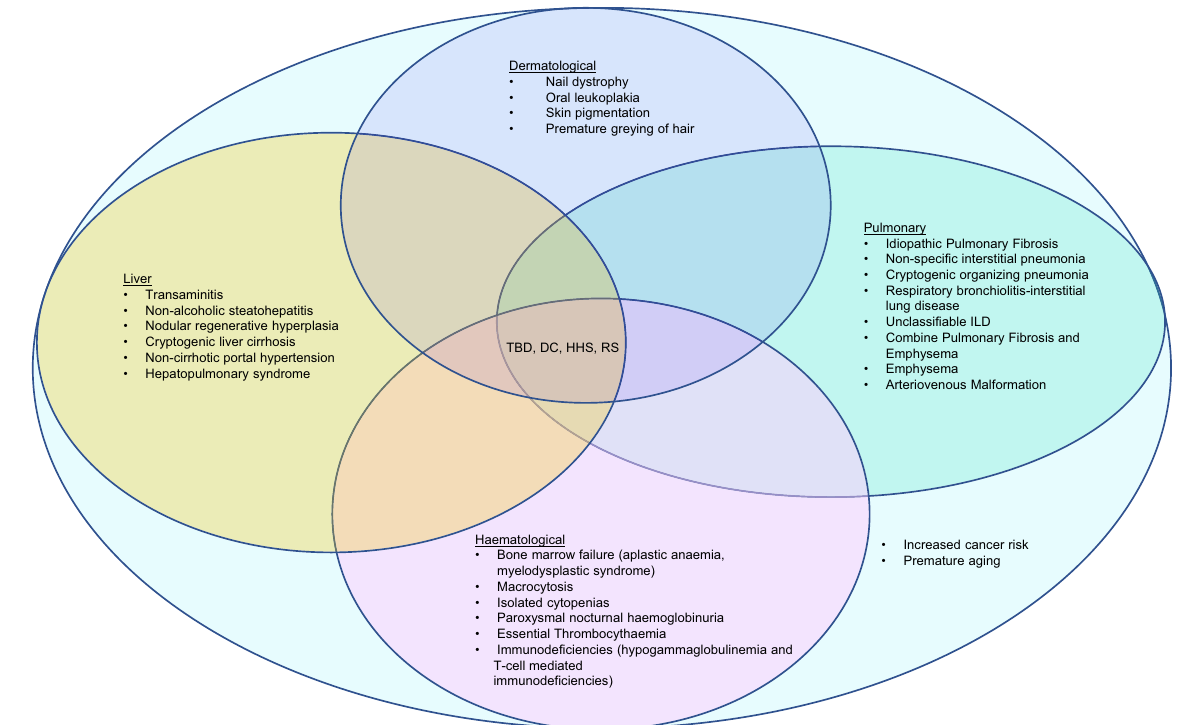
Fig. 5 Phenotypes of telomere biology disorders. The heterogenous presentation of telomere biology disorders manifestations may overlap and manifest at various time points or only following certain exposures or insults (e.g., radiation and immunosuppression as preconditioning regimens prior to bone marrow transplant may lead to pulmonary fi brosis in individuals who may have presented with isolated bone marrow failure). Regardless of clinical phenotype, patients are at increased risk of malignancies and disorders of premature aging. DC, dyskeratosis congenita; HHS, Hoyeraal – Hreidarsson Syndrome; ILD, interstitial lung disease; RS, Revesz Syndrome; TBD, telomere biology